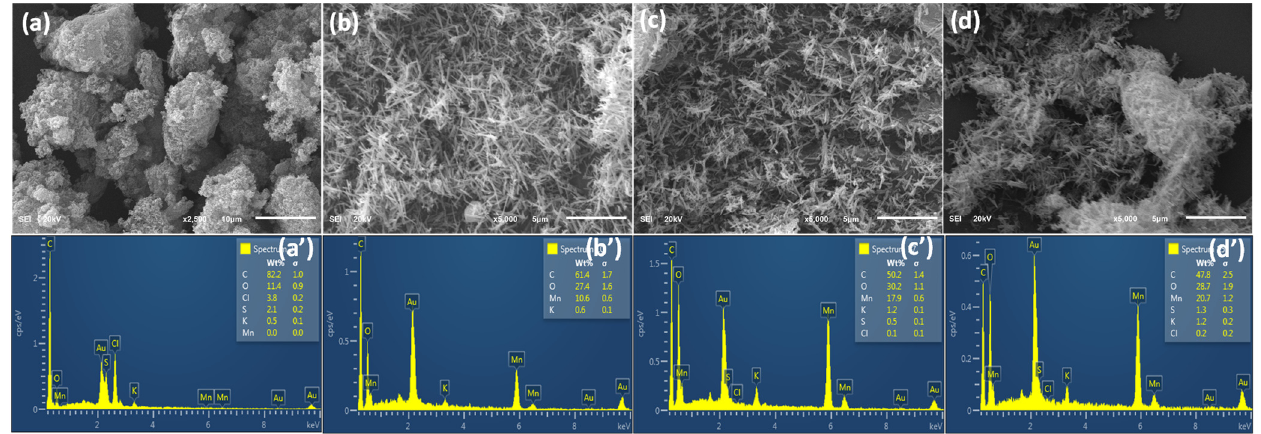
Figure 2. SEM images of ( a ) PP, ( b ) PMO-1, ( c ) PMO-2, and ( d ) PMO-3; EDS spectra of ( a’ ) PP, ( b’ ) PMO-1, ( c’ ) PMO-2, and ( d’ ) PMO-3. Thermal stability was examined using TGA analysis. All samples were analyzed in the temperature range from 25 to 800 ◦ C (Figure 3). The y-axis represents the weight loss, and the x -axis refers to sample temperature. The initial weight loss below 150 ◦ C corresponds to the removal of physio-absorbed water molecules from the samples